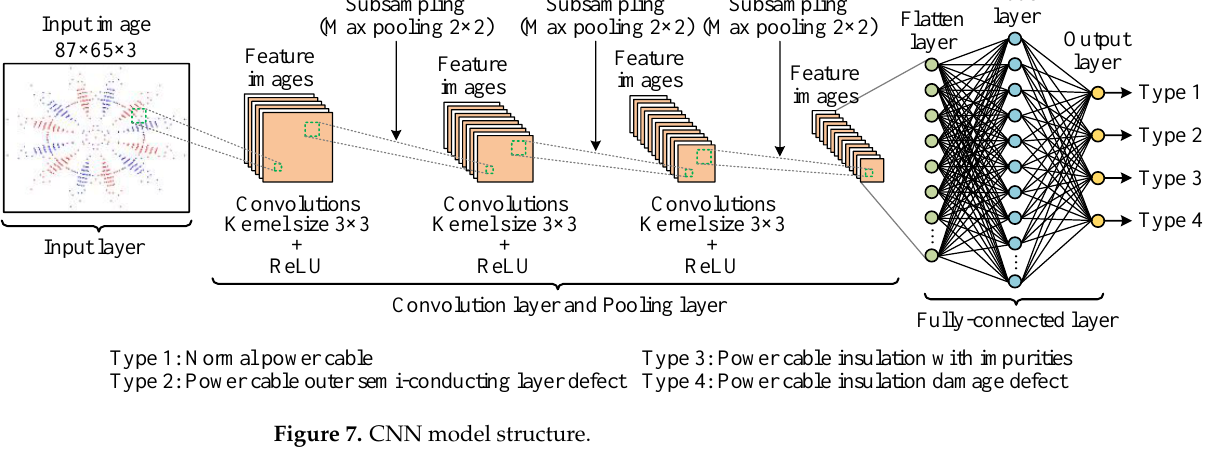
Figure 7. CNN model structure. Figure 7. CNN model